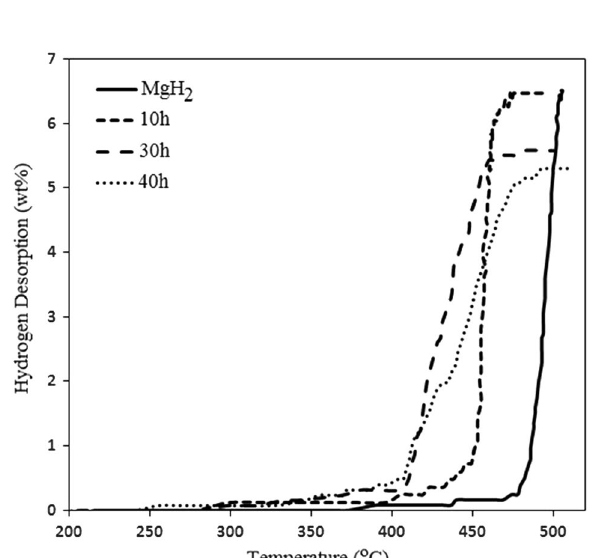
Fig. 5 Hydrogen desorption behavior of as-received MgH milled MgH 2 for 10, 30, and 40